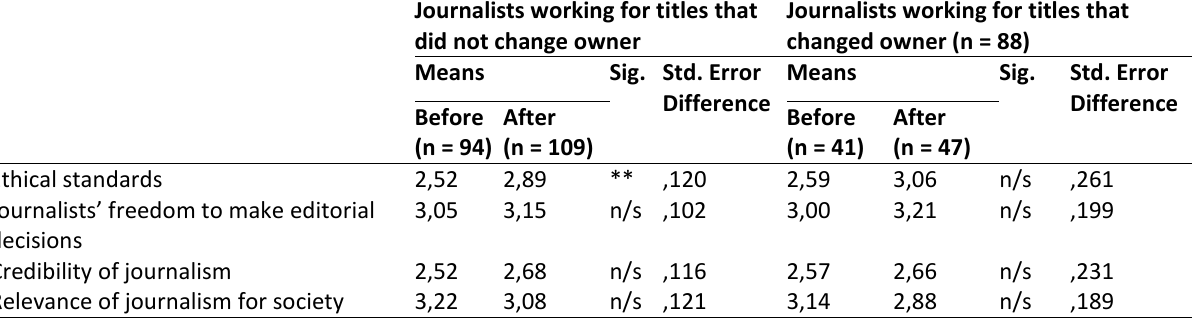
Note: values: 1 = not influential; 5 = extremely influential. Table 5. Perception of the changes in journalism before and after the media takeover in 2013 (means, independent samples